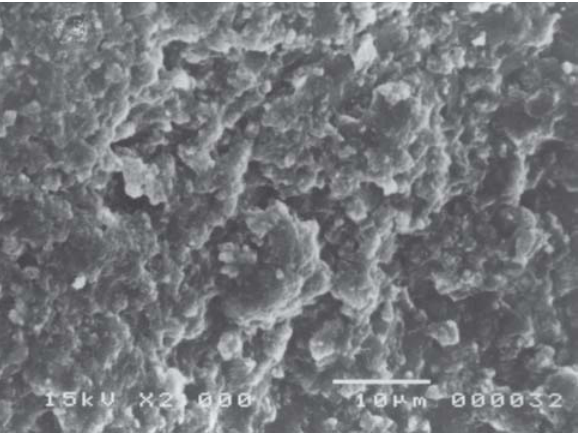
FIGURE 5- SEM micrograph of cohesive failure (G-IV – 2000x)